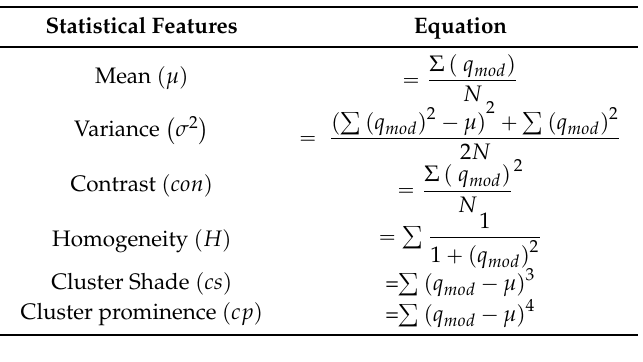
Table 3. Statistical features extracted using